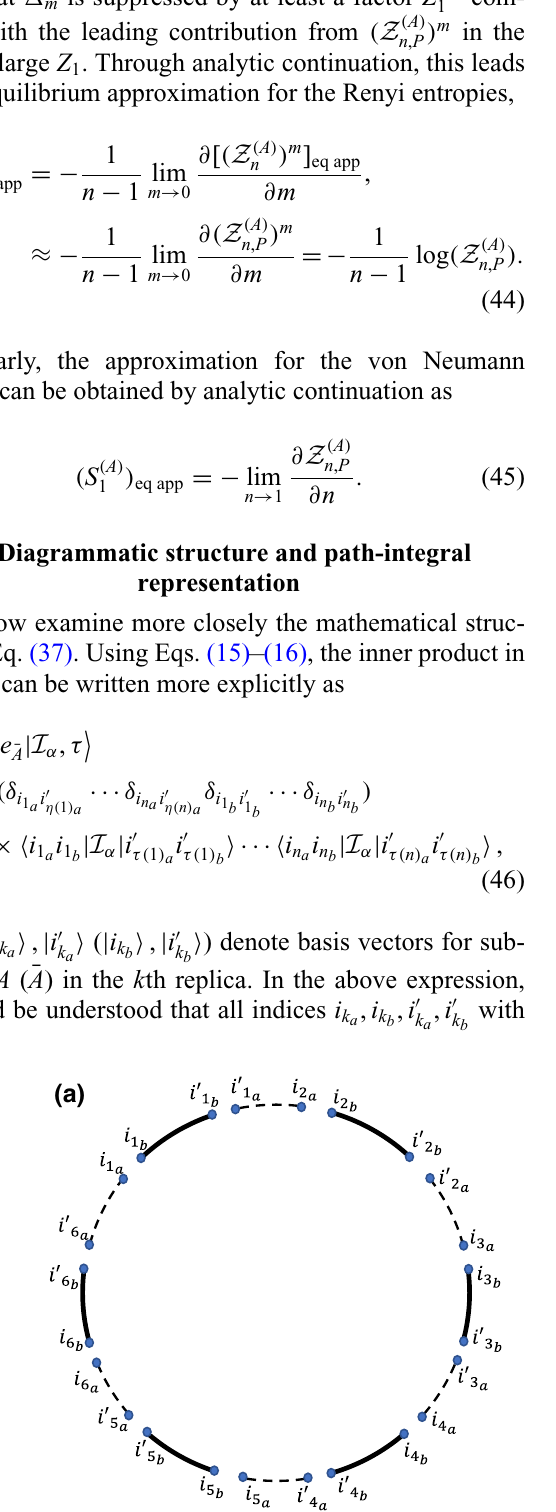
FIG. 2. (a) The “future conditions” for each of the Z ( A ) show an example of how to connect indices in the interior of the diagram for a permutation τ such that τ( 1 ) = 3, and the factor of